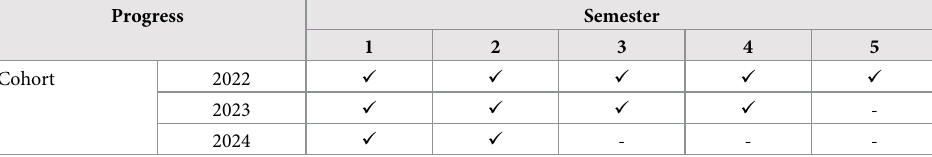
Table 2. Illustrating the respective cohorts progress in the research module under